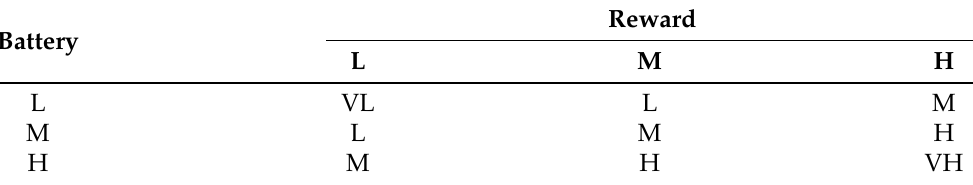
Table 2. The rules used in the Fuzzy system for the TOP.